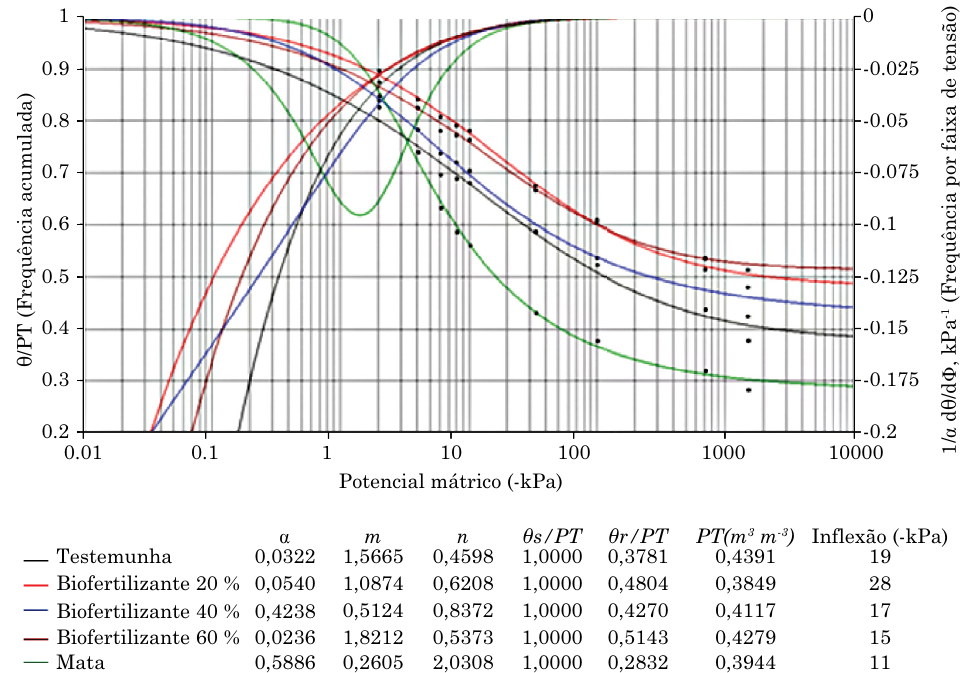
Figura 6. Curva característica de água no solo e curva diferencial da curva característica de água no solo para as áreas sob cultivo de figo e mata secundária na camada de 0,0-0,1 m.